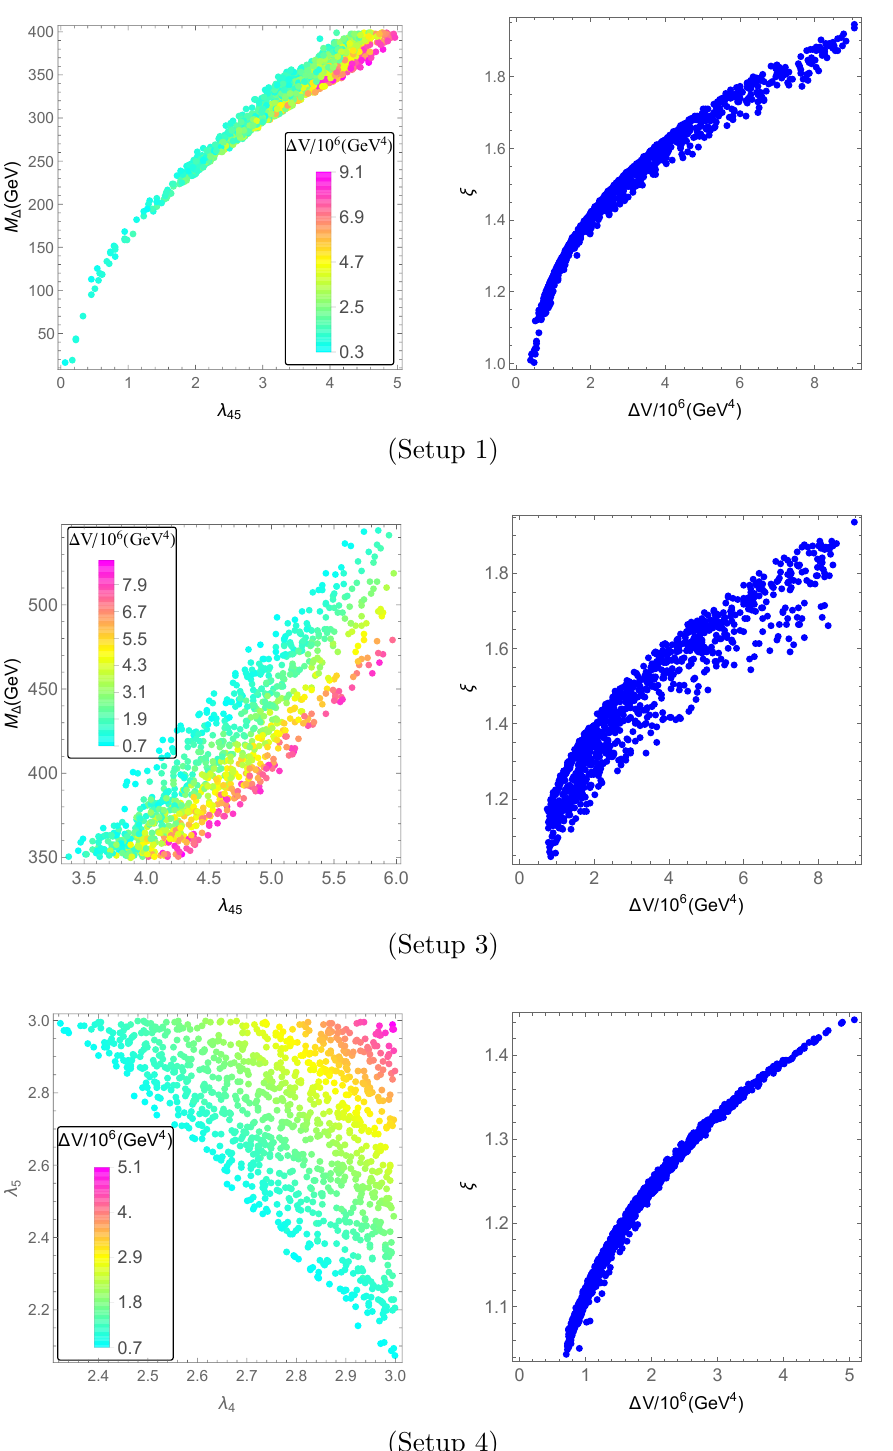
Figure 2 . The height of the potential barriers and the ξ for various λ 45 and M ∆ for the four setups. Note that setup 2 is missing due to the fact that the decoupling of the heavy